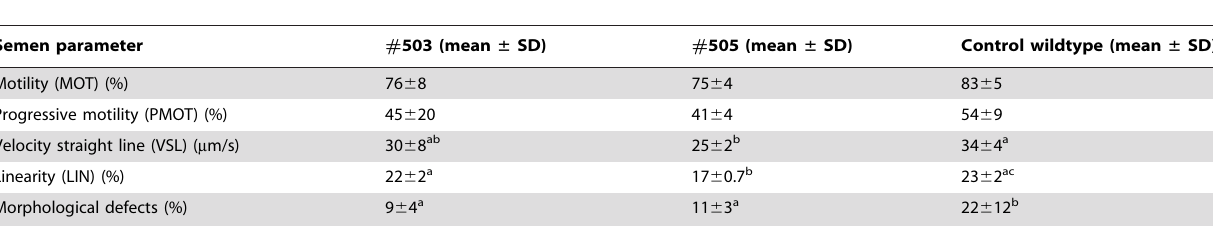
Table 2. Semen parameters measured in fresh samples from transgenic and control boars.